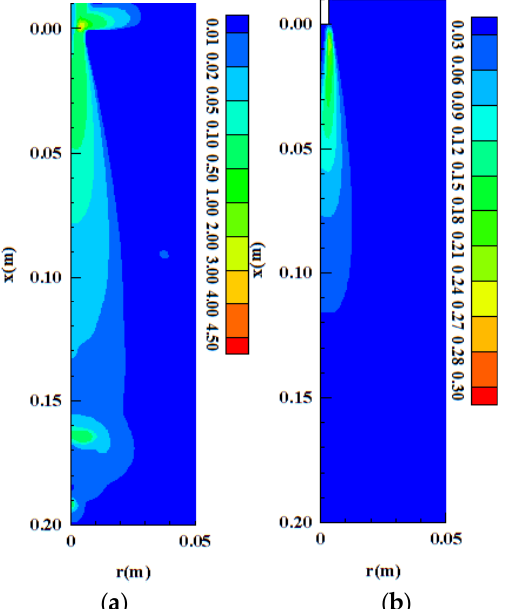
Figure 12. The TKE (m 2 /s 2 ) distribution for ( a ) a plunging jet with V 0 = 2 m/s, L 1 = 0.025 m ( V 1 = 2.12 m/s) and ( b ) a submerged jet with V 0 = 2.12 m/s, L 1 = 0 m ( V 1 = 2.12 m/s).